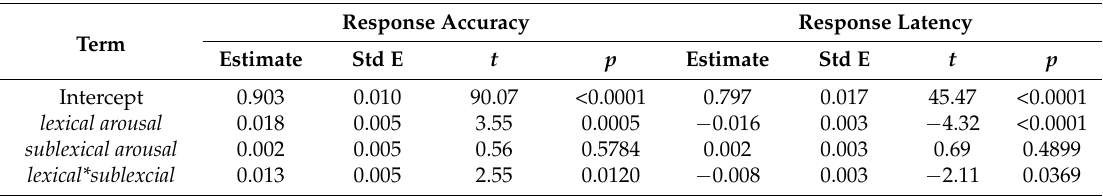
Figure 2. Congruent words (iconic) were classified more quickly ( right ) and more accurately ( left ) in the corresponding lexical group compared to incongruent words (non-iconic). Table 2. Results of fixed effects, the interaction term, and the intercept of the mixed model